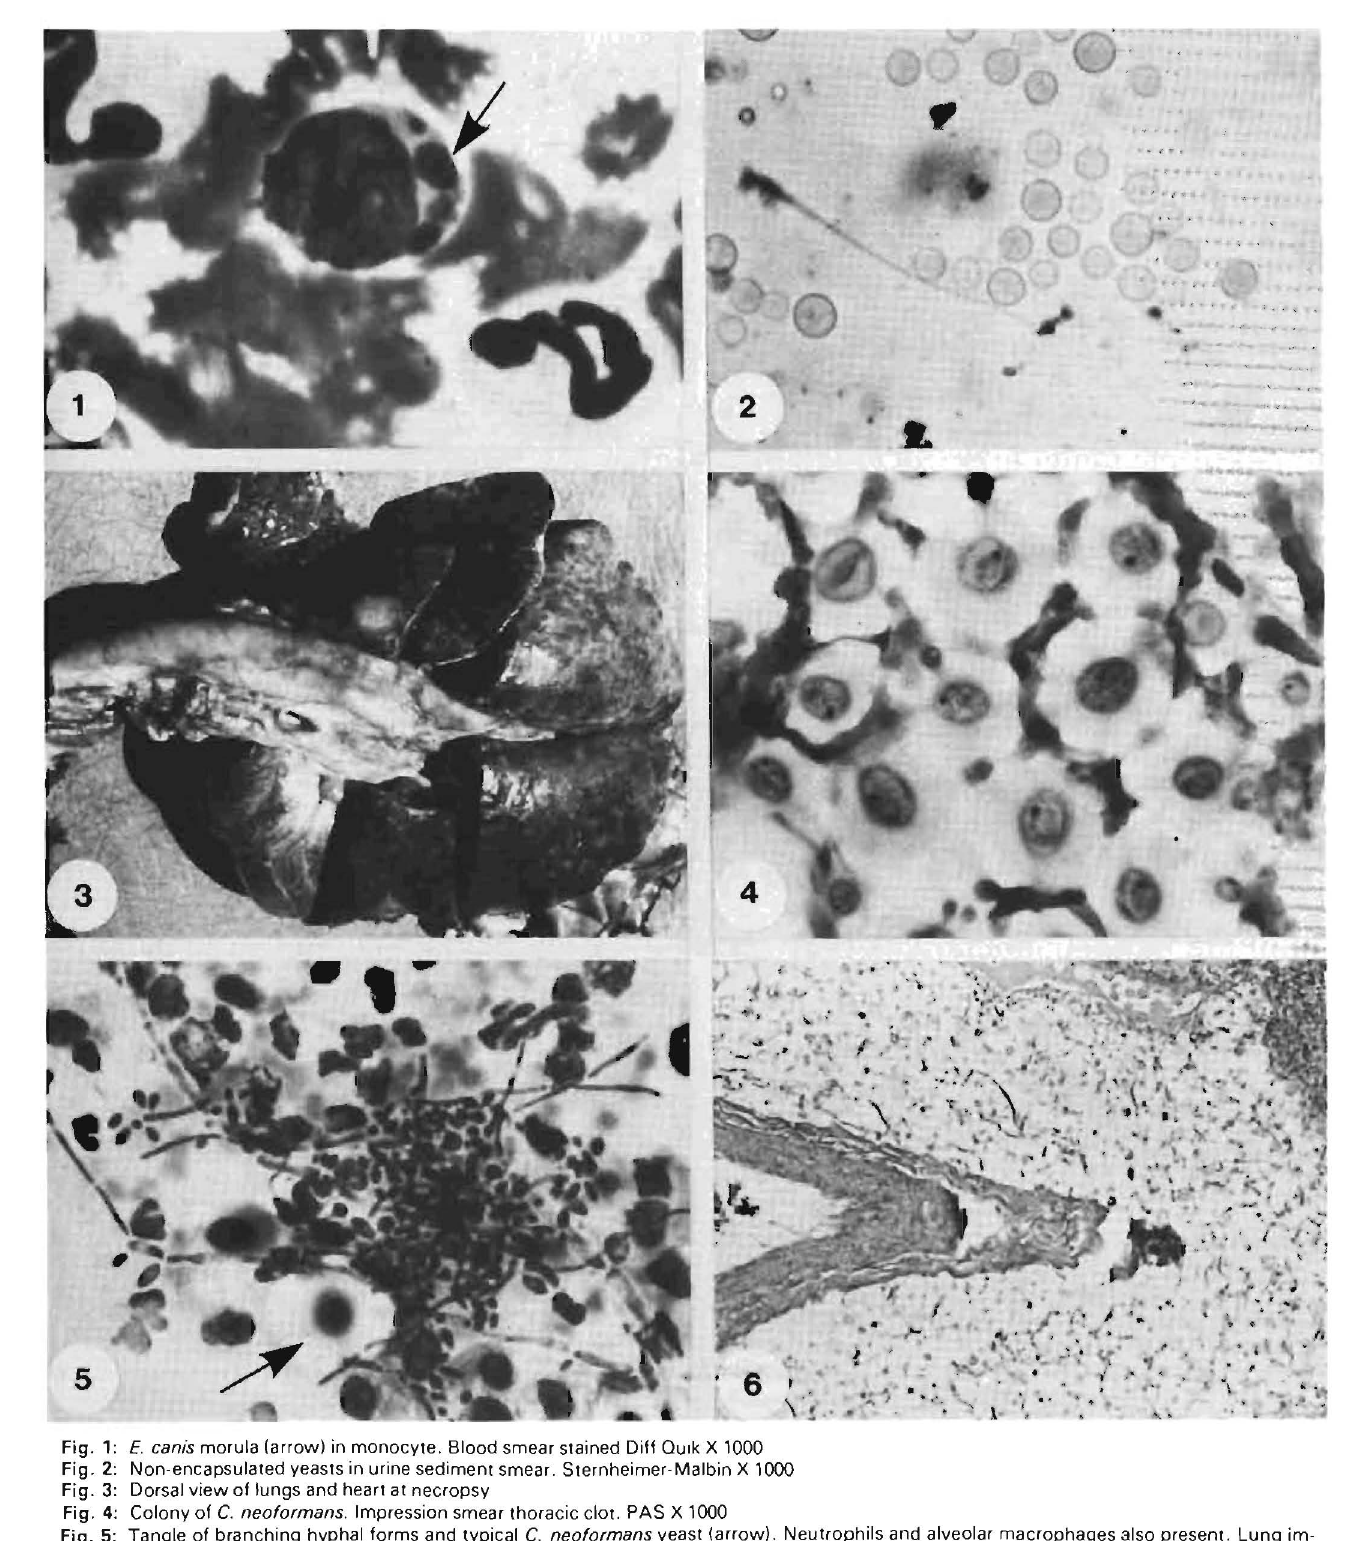
Fig. 1: E. canis morula (arrow) in monocyte. Blood smear stained Diff OUlk X 1000 Fig. 2: Non-encapsulated yeasts in urine sediment smear. Sternheimer-Malbin X 1000 Fig. 3: Dorsal view of lungs and heart at necropsy Fig. 4: Colony of C. neoformans. Impression smear thoracic clot. PAS X 1000 Fig. 5: Tangle of branching hyphal forms and typical C. neoformans yeast (arrow). Neutrophils and alveolar macrophages also present. Lung im pression smear. Giemsa X 400 Fig. 6: Lung - large perivascular colony of C. neoformans. HE x 40 JOURNAL OF THE SOUTH AFRICAN VETERINARY ASSOCIA nON